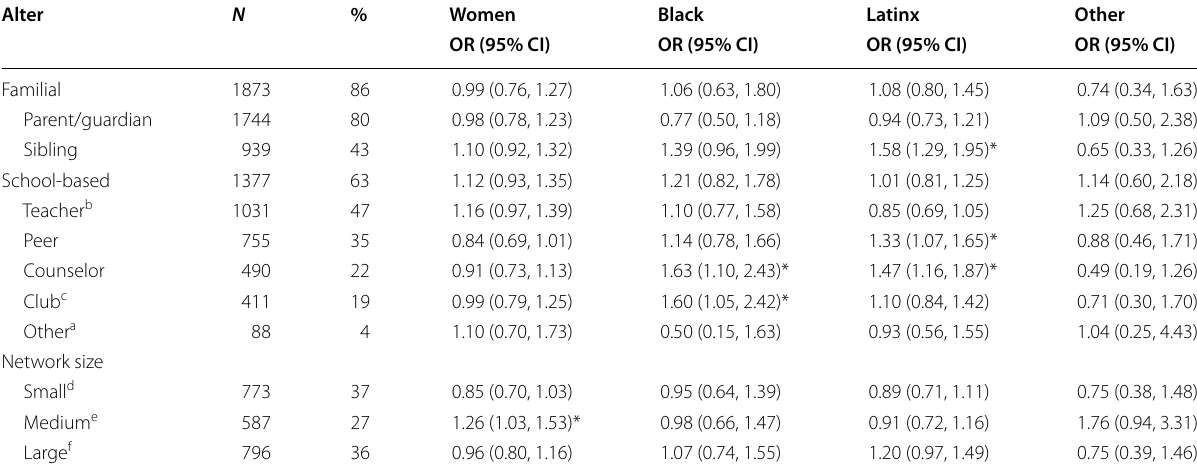
OR odds ratio, CI confidence interval *Statistically significant at 0.05 level a Other non-family and non-school related alters, such as celebrity, radio broadcaster, or